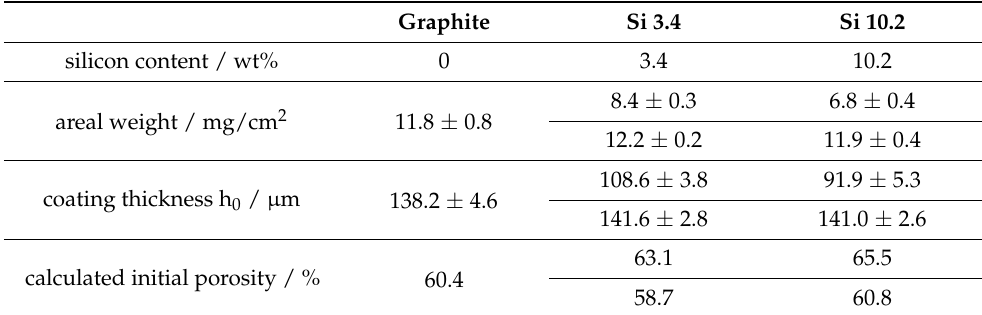
Table 2. Electrode parameters of the non-calendered